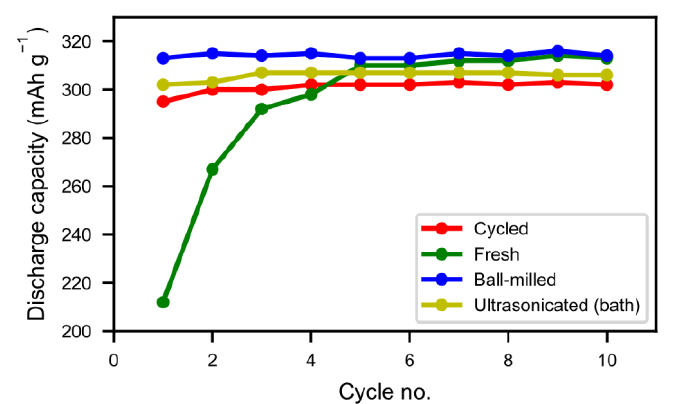
Figure 8. Average capacity measured for the first 10 cycles of the treated and untreated samples. For all 10 cycles, a discharge rate of 60 mA g −1 (0.2 C) was used. The measured capacity was adjusted to take the added Ni in the electrode fabrication into account.